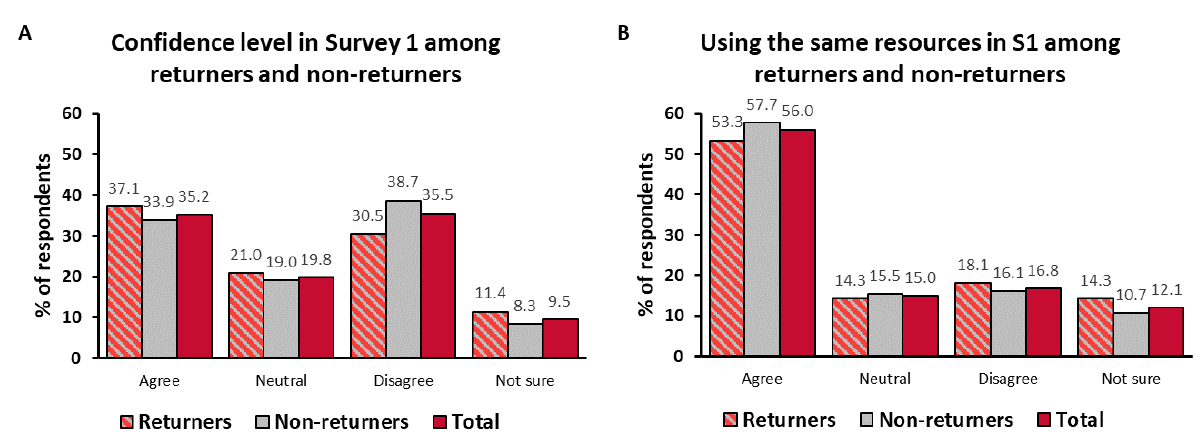
Note. Figure 3.A: Confidence with telepractice delivery in Survey 1 among returners (light red, striped, n = 105), non-returners (gray, n = 168) and the total number of respondents (red, n = 273); Figure 3.B: Resource utilization in Survey 1 among returners (light red, striped, n = 105), non-returners (gray, n = 168) and the total number of respondents (red, n =